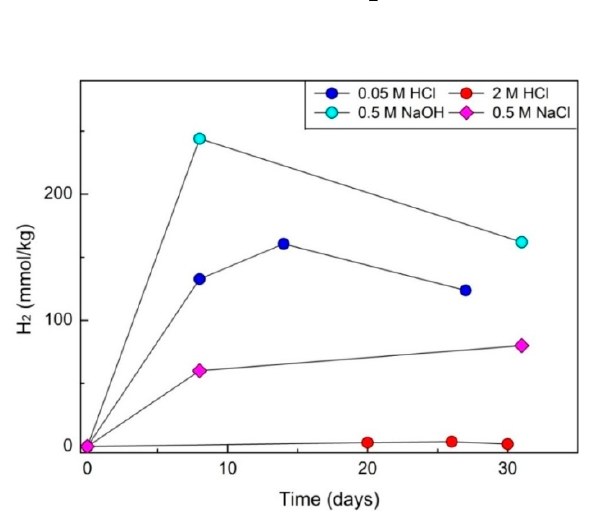
/ kg) after serpentinization of peridotite as a function of